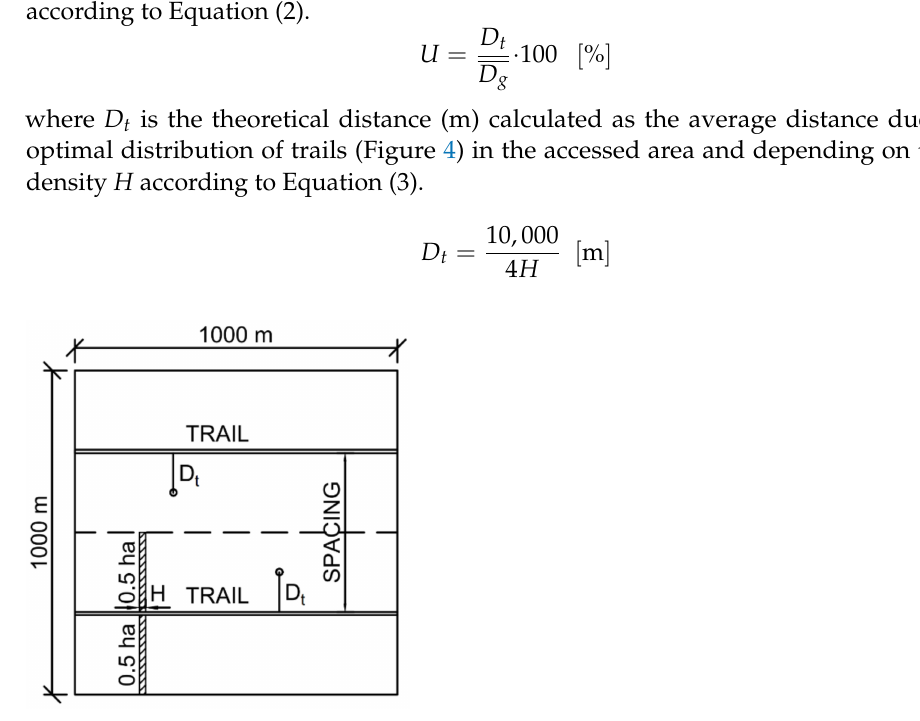
Figure 4. Theoretical distance, D t , due to the optimal trail distribution in the forest access area and trail density, H 20